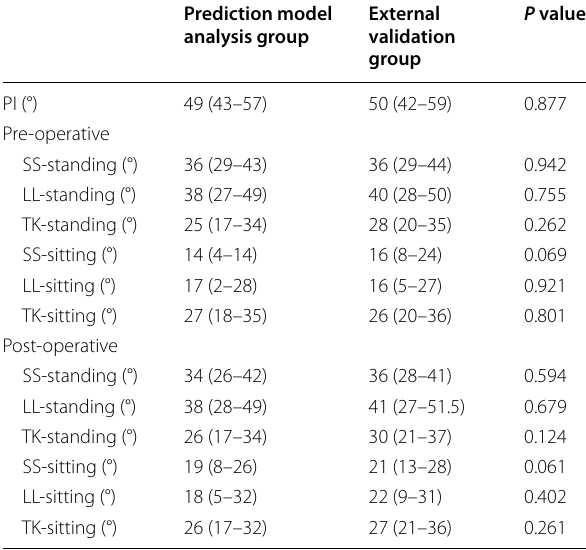
Table 2 Pre- and postoperative spinopelvic